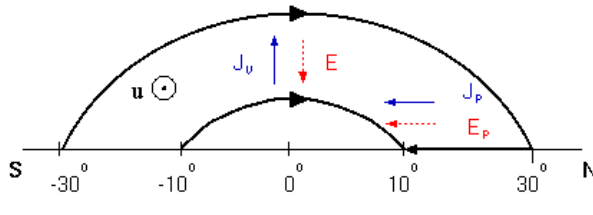
Fig. 9. Schematic representation of the vertical currents driven by the F-region dynamo and the Petersen closure currents in the E-